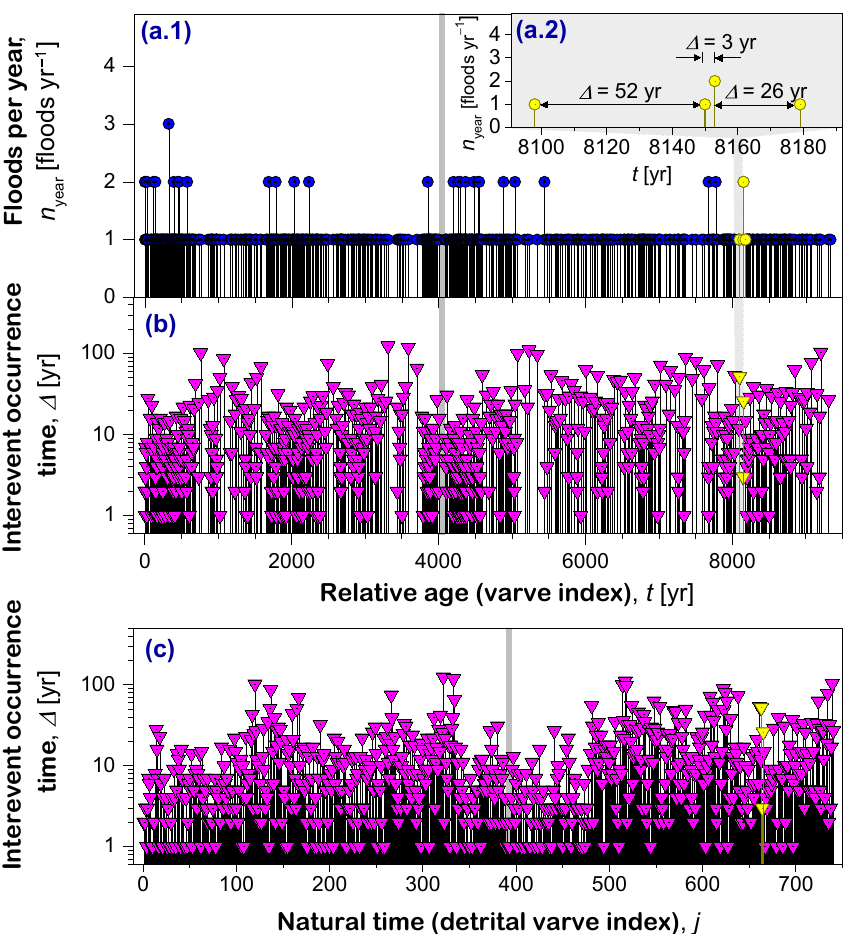
Figure 4. Data series of detrital layers (floods) and interevent occurrence times (IEOTs) from the Piànico–Sèllere, Italy, palaeoflood sequence. (a) In panel (a.1) are shown the number of detrital layers (floods) per varve, n year , given as a function of varve index t = 1 to 9336 years (blue dots – data available at Mangili et al., 2017) as shown in Fig. 3. In panel (a.2) a 100-year portion of (A.1) (from t = 8090 to 8190 years) is expanded with an illustration of 4 flood years that have detrital layers (floods) in them, and the interevent occurrence times (cid:49) between them. These 4 flood years, each with n year ≥ 1 flood in them, appear as yellow symbols in all panels. ( b ) Interevent occurrence times, (cid:49) , temporally located (i.e. as a function of the relative age) when they occurred. ( c ) Interevent occurrence times, (cid:49) j , plotted as a function of “natural” time, where each (cid:49) is no longer represented temporally when it occurs, but rather successively one after another, j = 1, 2, 3, ..., 741; interevent occurrence times of (cid:49) j = 0 are not shown. The detrital varve index j includes only those years (varves) where there are n year ≥ 1 floods yr − 1 (i.e. at least one detrital layer in that